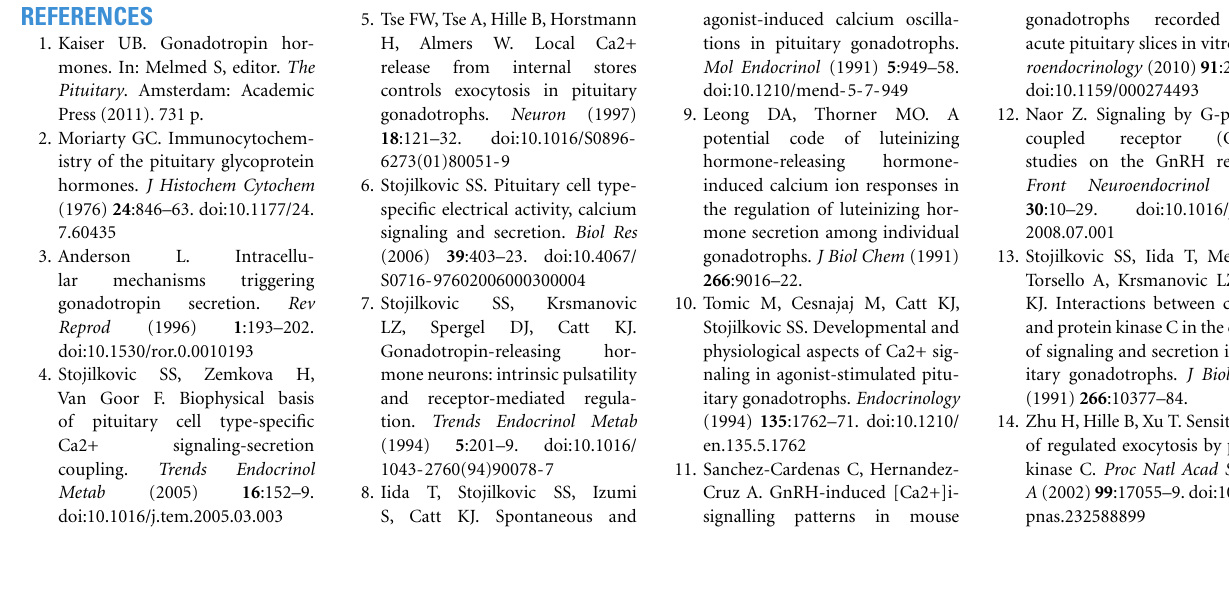
cell area (Mean ± SE). (C) Intact ( n = 6) and (D) 15days post-GnX ( n = 6) mice pituitary slices are represented; dashed line represent the confidence interval. (C) y =− 0.11* ± 0.11x + 31.1 ± 5.1, R 2 = 0.15, p > 0.05, Pearson r = 0.38, p > 0.05and (D) y = 0.16* ± 0.02x + 17.88 ± 2.3, R 2 = 0.73, p < 0.05, Pearson r = 0.85, p < 0.05. Parts of this figure were originally published in Durán-Pastén et al.,